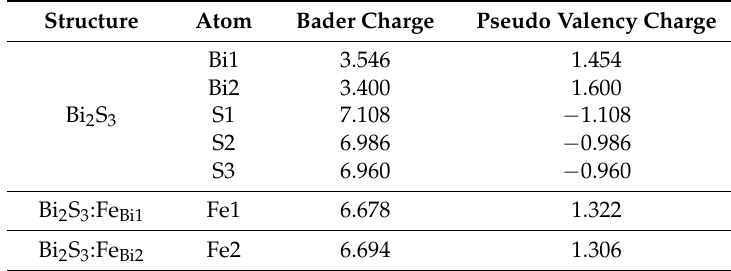
Table 2. Bader charge calculated from pseudo valency electron density for Bi 2 S 3 bulk, Fe-doped Bi 2 S 3 bulk at Bi1 and at Bi2 sites. Pseudo valency charge is the difference between the free atom valency charge and the Bader charge. All charges in units of | e |, where e is the elementary charge. Structure Atom Bader Charge Pseudo Valency Charge